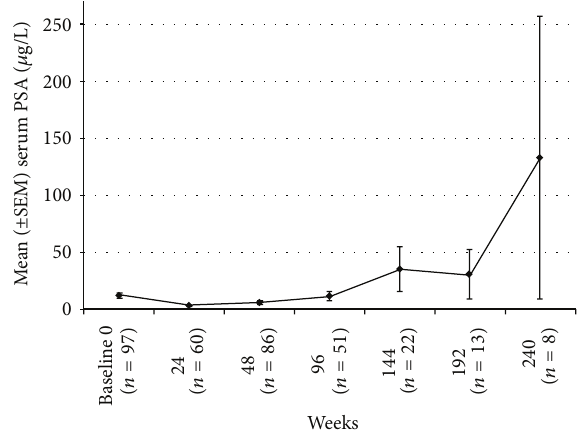
Figure 2: Mean serum prostate-specific antigen (PSA, 𝜇 g/L) levels in patients after receiving once-yearly histrelin acetate implants for 240 weeks. The error bars represent the standard error of the mean